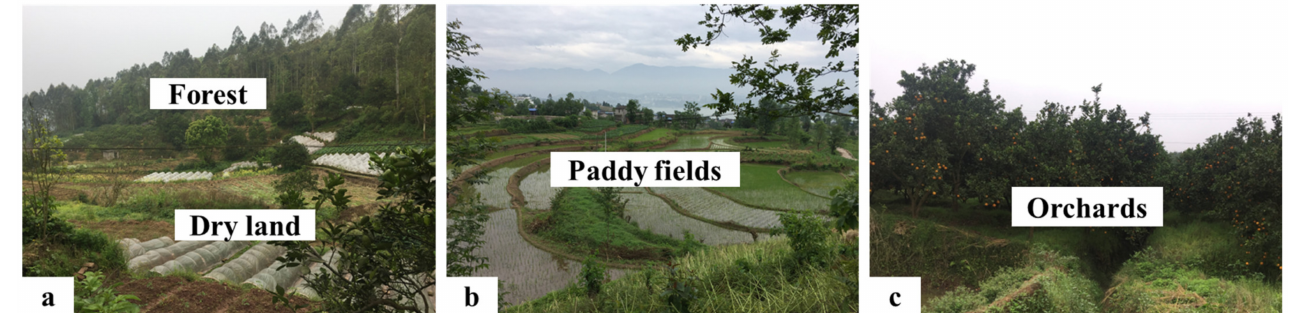
Figure 2. Landscape of potential sediment sources of ( a ) forest and dry land; ( b ) paddy fields; and ( c )